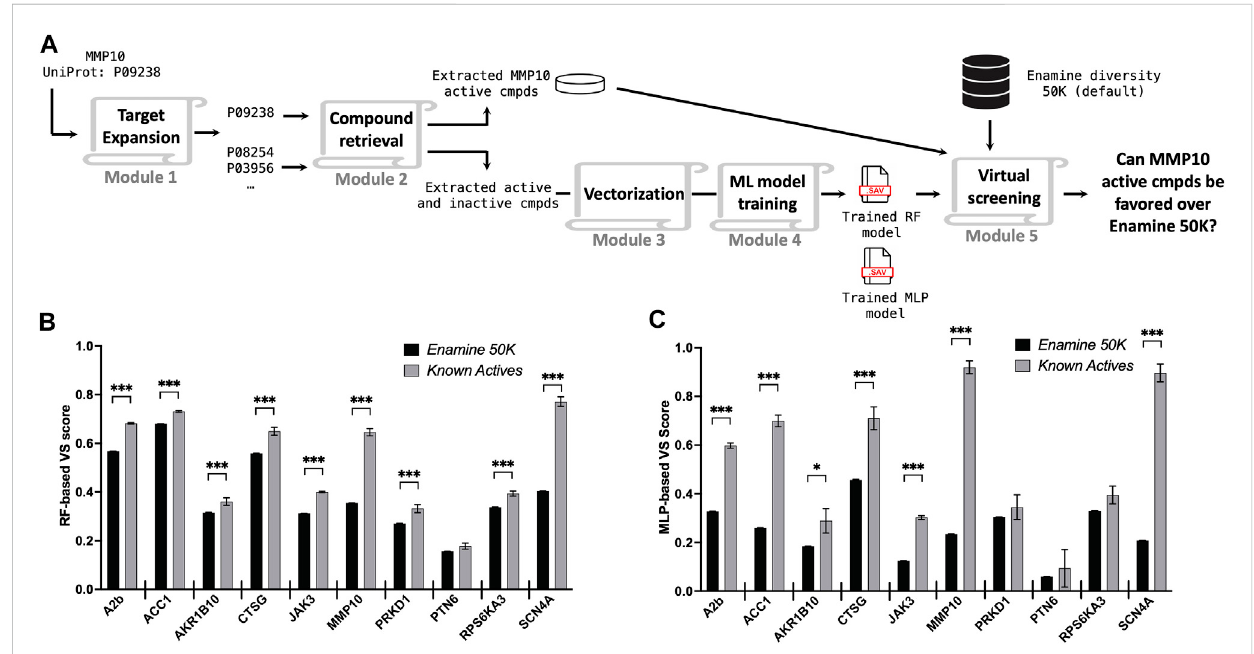
FIGURE 3 Retrospective validations across ten different protein targets. (A) Schematic illustration of aretrospective study. Averaged VS scores reported by the RF model (B) and the MLP model (C) for the entire Enamine diversity 50K library (black bar) and known active compounds (gray bar) of the query target. The error bar represents the standard error of the mean (SEM), * p < 0.05; ** p < 0.01; *** p <